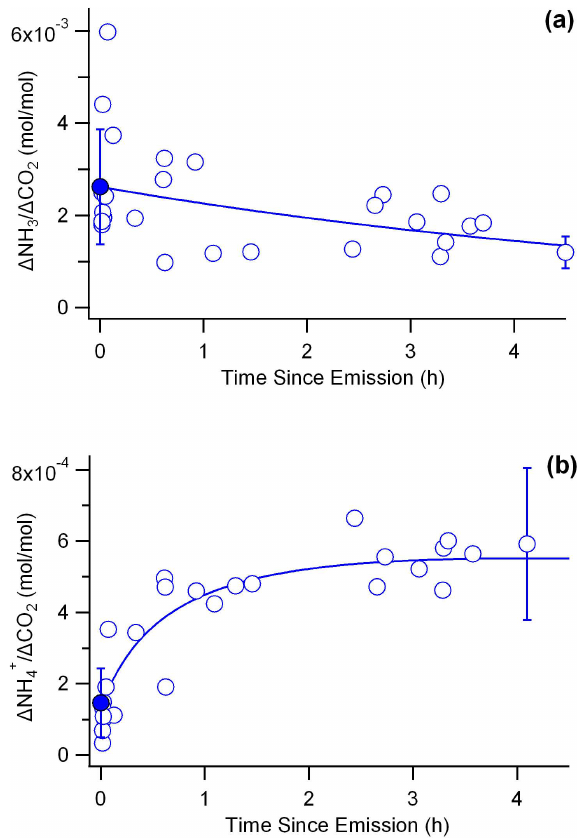
Fig. 8. (a) 1 NH 3 / 1 CO 2 molar ratio vs. time since emission (h). The decay in 1 NH 3 / 1 CO vs. time since emission is slightly better correlated, but we show 1 NH 3 / 1 CO 2 here for direct comparison to the AMS data in Fig. 8b. Points were fit to an exponential trend- line. (b) 1 NH + / 1 CO 2 molar ratio vs. time since emission (h). 4 Note difference in y-scale. Points were fit to a logarithmic trend- line. For both (a) and (b) , ERs (solid circles) are shown with an error bar reflecting the standard deviation in the mean of the ten source measurements. We retain all source samples to show the in- herent variability in source measurements. Downwind error bars are an estimate of the uncertainty in the oldest individual downwind